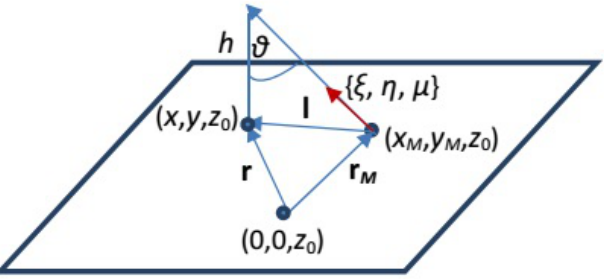
Figure 1. The arrangement of the ray reflected from point r M and captured by the sensor located at some height h above point r .